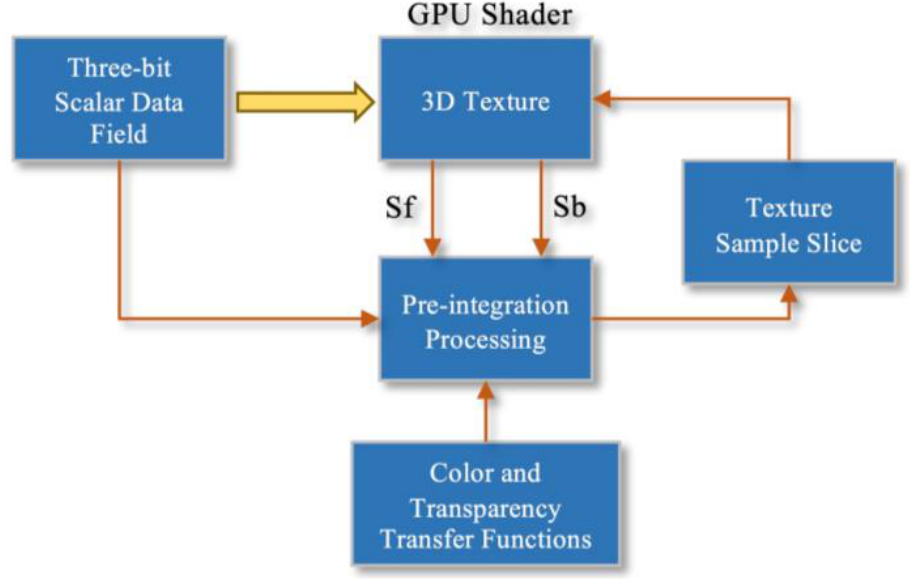
Figure 12. Pre-integrated volume visualization implementation steps.